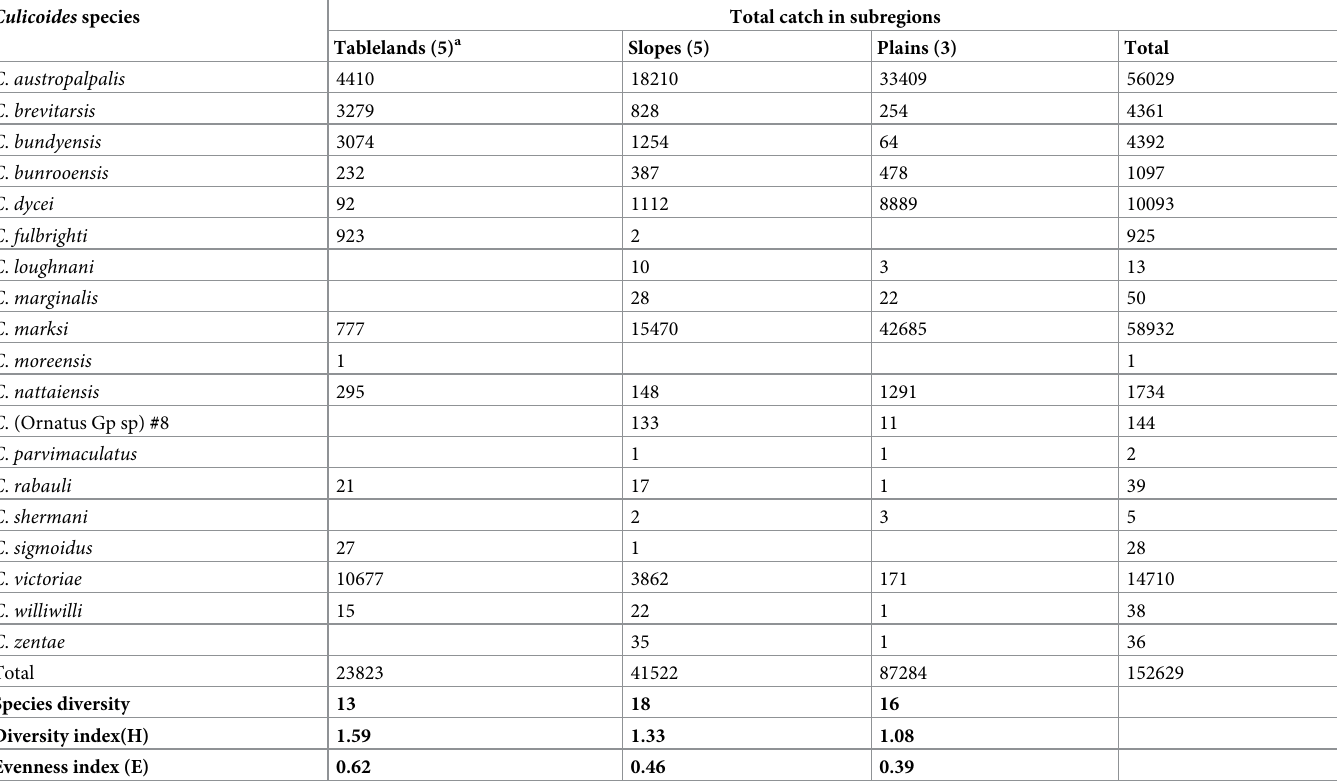
Table 5. Shannon-Wiener diversity and evenness indices of Culicoides species in New England subregions of NSW, Australia. Culicoides species Tablelands (5)